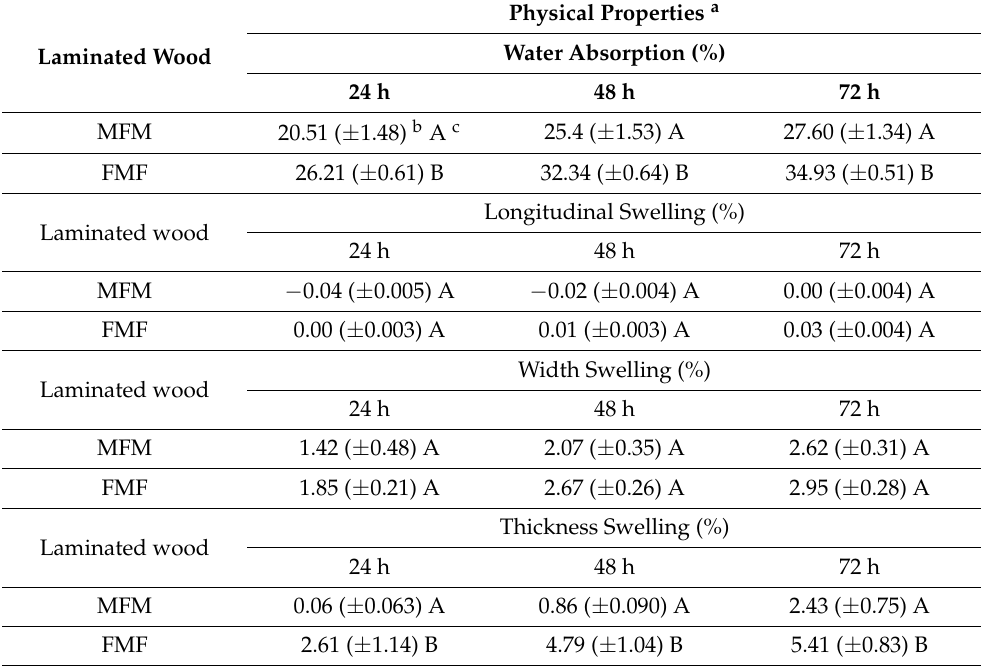
Table 3. Physical properties of the two types of laminated wood.